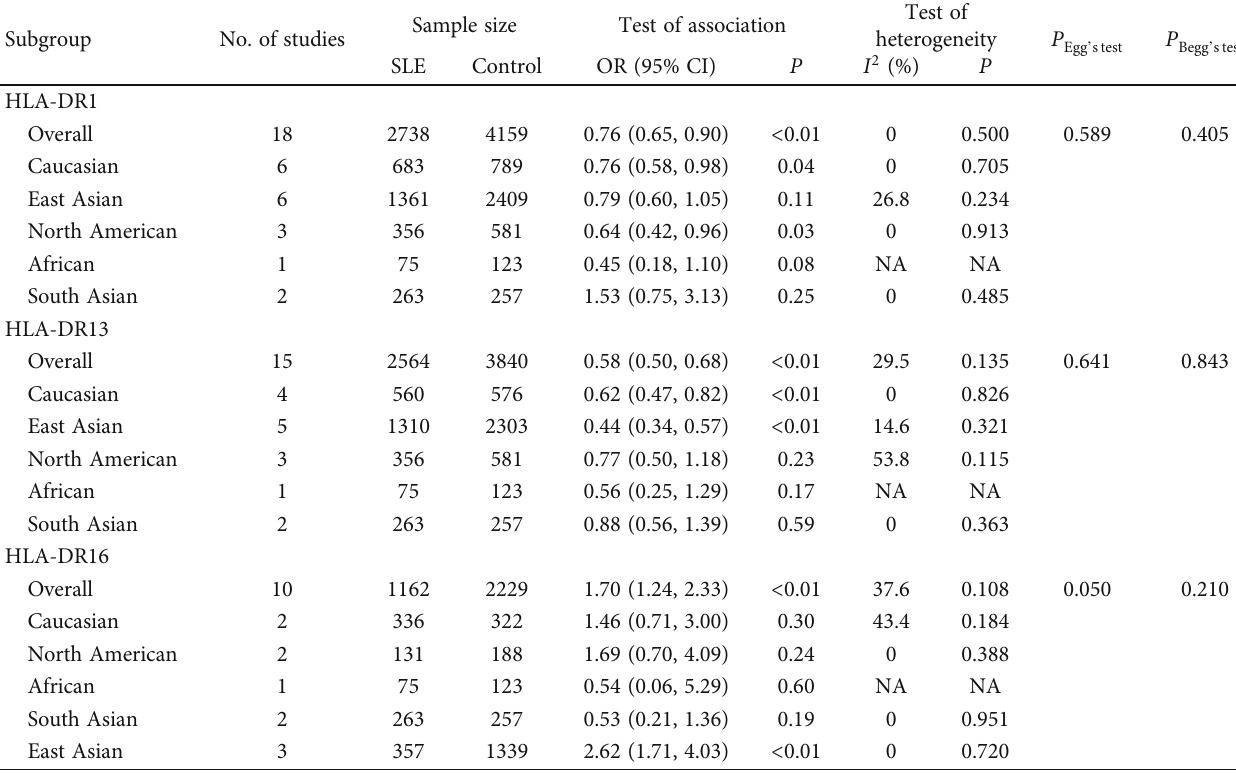
Table 3: Results of the association between HLA-DRB1 (HLA-DR1, HLA-DR13, and HLA-DR16) polymorphisms and SLE susceptibility in this